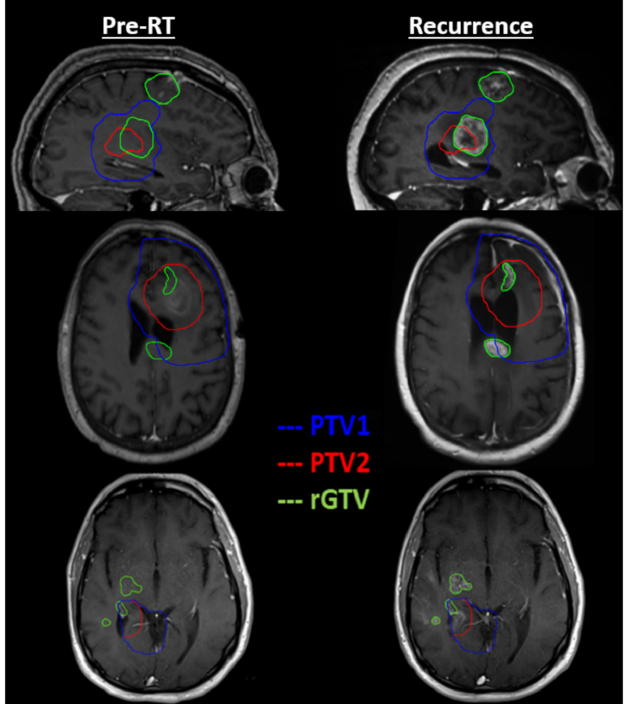
Figure 3. T1 post-contrast imaging in three patients, by horizontal row, with out of field recurrence in cohort 2. For each patient, the enhancing recurrence contour (rGTV) encompasses lesion that has spread outside the extent of radiation treatment targets PTV1 (guided by T2/FLAIR) or PTV2 (guided by